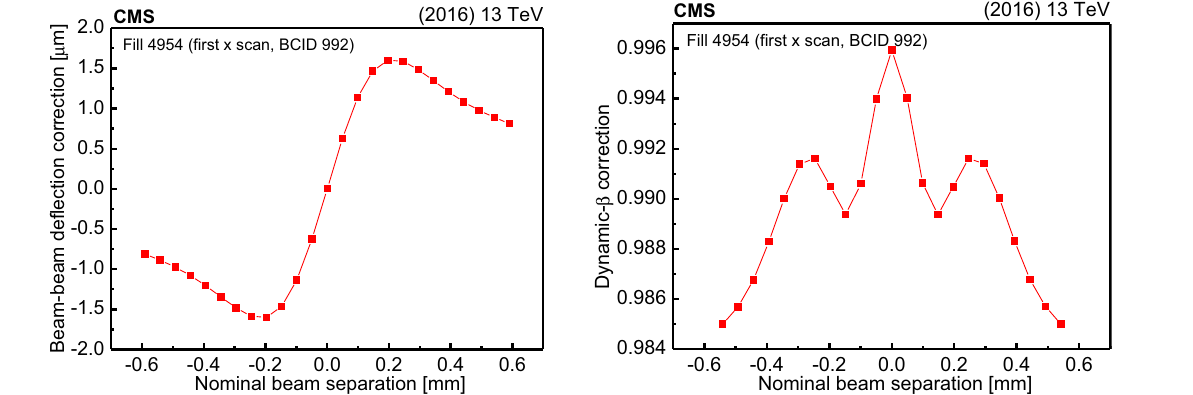
parameters associated with fill 4954 (first scan, BCID 992). Lines rep- resent first-order polynomial interpolations between any two adjacent